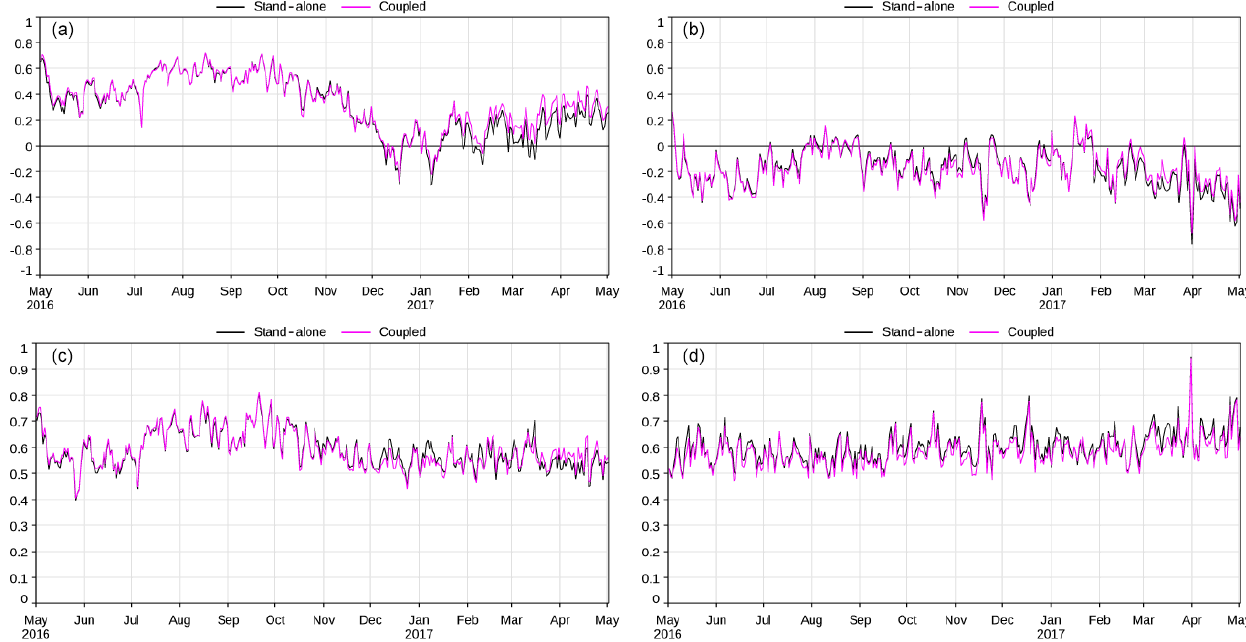
Figure 12. MNMB (a, b) and FGE (c, d) of daily near-surface PM 2 . 5 (a, c) and PM 10 (b, d) (µgm − 3 ) simulated by stand-alone (black) and coupled (violet) cycle 45R1 against North American observations from the AirNow